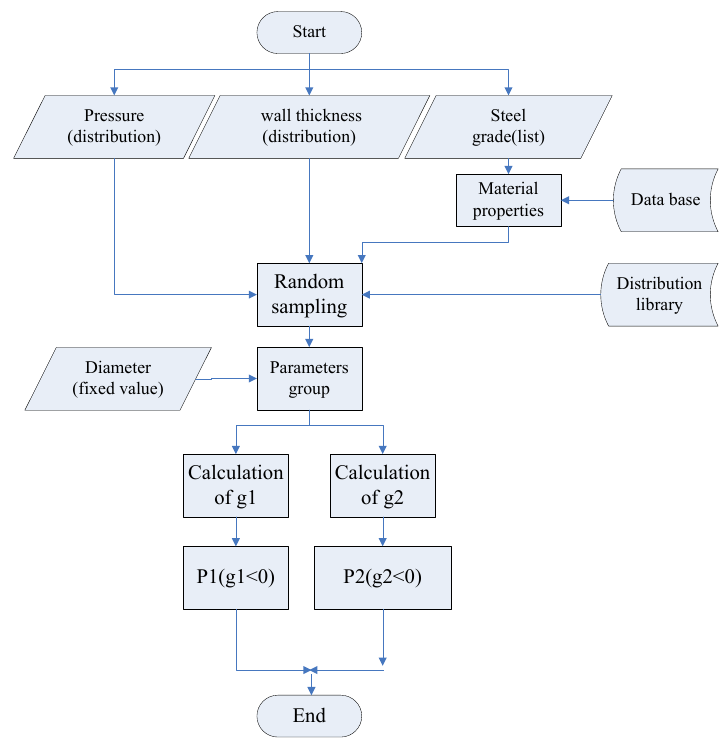
Figure 3. Monte Carlo simulation process.